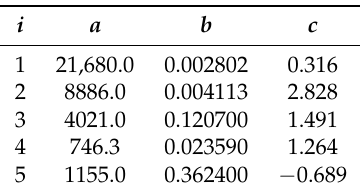
Figure 8. ARI data and sum of sines one-week projection for 2017–2018 winter season. Table 1. Values of the adjusted parameters using the non linear least squares fitting method. Each row i represents the parameters affecting the i th sine.